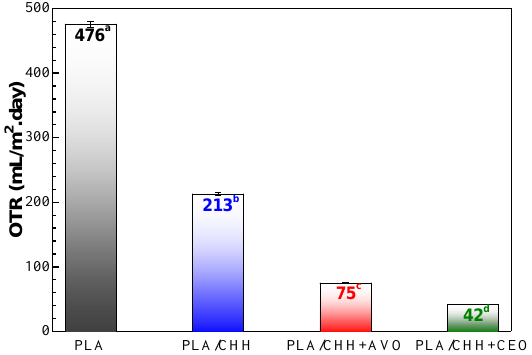
Figure 4. Oxygen transmission rate (OTR) of PLA-based films and surface modified with oil-loaded chitosan coatings. The data are expressed as mean ± standard deviations from triplicate determinations. a-d Mean values with different letters indicate significant differences at p < 0.05.